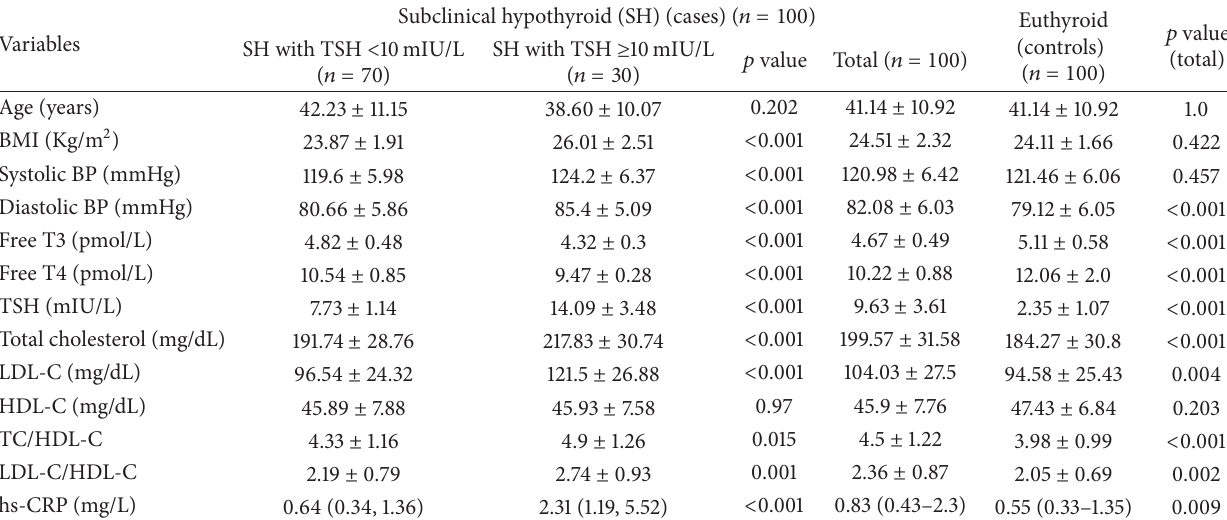
Table 1: Characteristics of the study